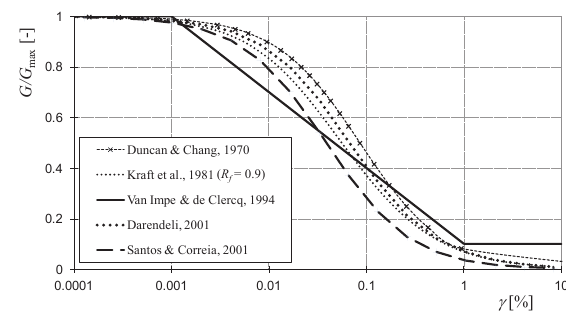
Figure 2: Comparison of the G modulus degradation function Fig. 2. Comparison of the G modulus degradation function according to the selected formulas. according to the selected